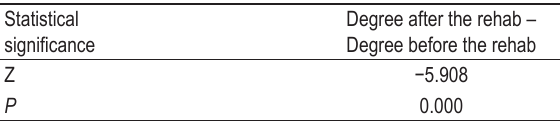
TABLE 6. Statistical significance of the disability degree before